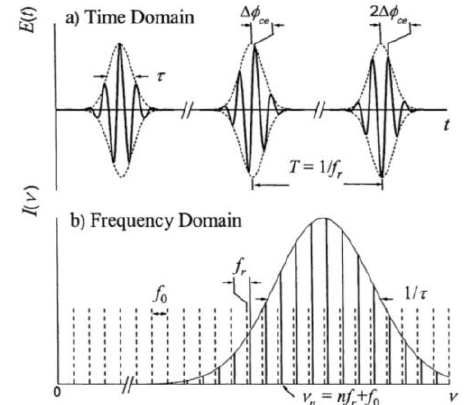
Figure 2 Standard comb: time (upper) and frequency (down) domain